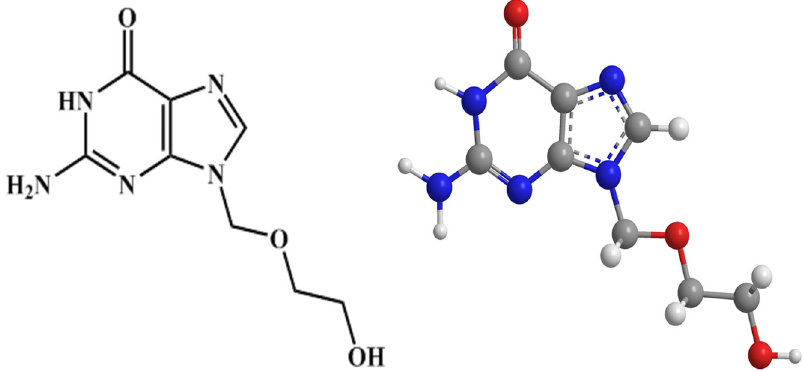
Figure 1. Molecular structure of ACV.